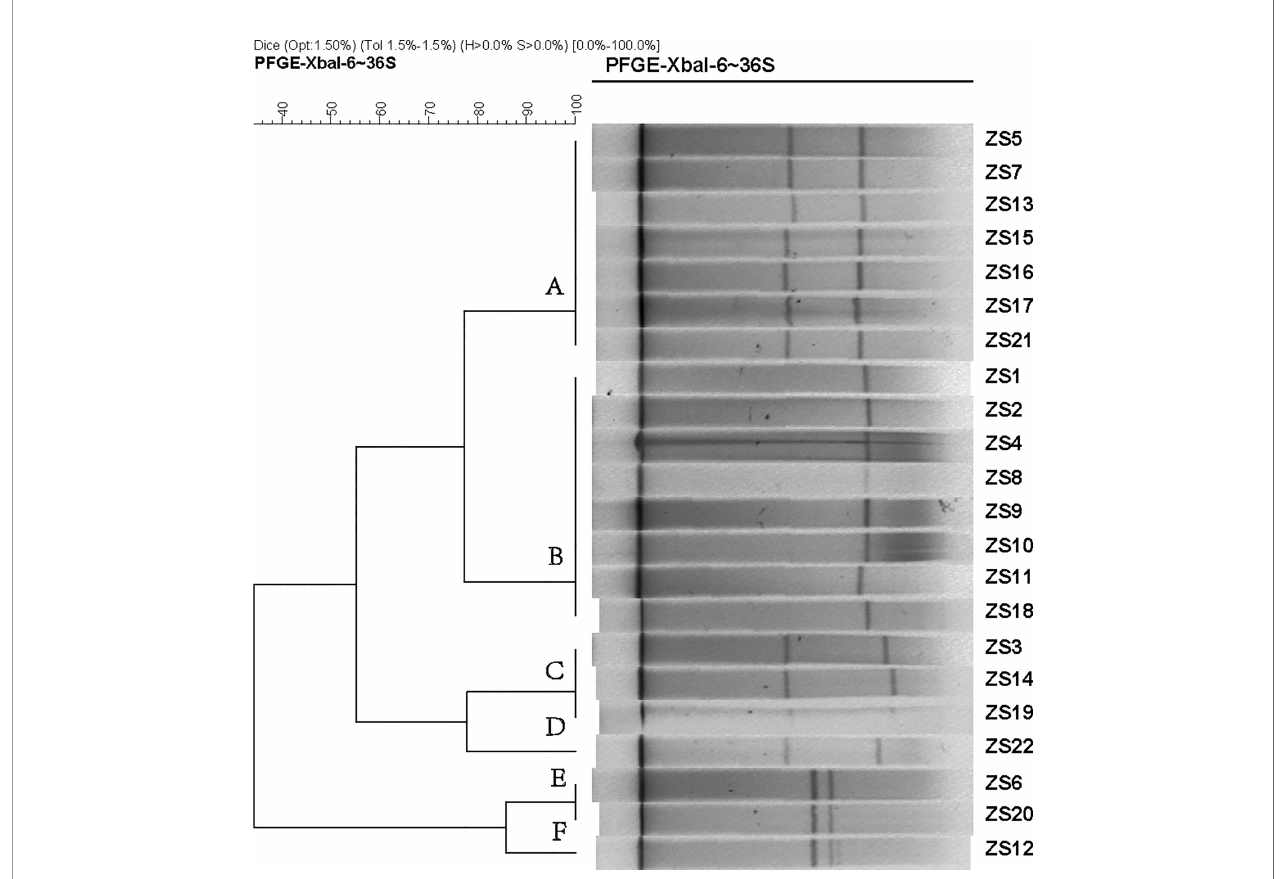
FIGURE 1 | Dendrogram generated by BioNumerics software (Version7.1, Applied Maths, St-Martens-Latem, Belgium) showing cluster results of molecular epidemiology S1-PFGE analysis of 22 K. pneumoniae isolates. Band-based similarity coef fi cients were calculated using Dice coef fi cient and unweighted pair group average method algorithm (UPGMA). Salmonella enterica serotype Braenderup strain H9812 was digested with XbaI and used as a molecular size marker. The electrophoresis conditions were as follows: initial switch time, 3 s; a fi nal switch time, 36 s; gradient, 6 V/cm; angle, 120; temperature, 14°C and time, 18.5